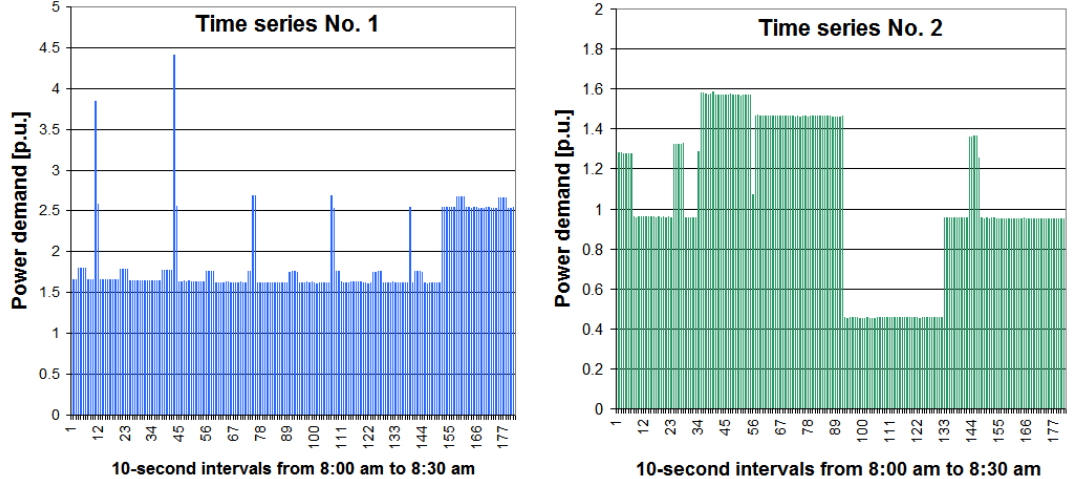
Figure 2. The two daily time series of power demand for the analyzed December day (figure of time series No. 1 is similar to the one from [44]).